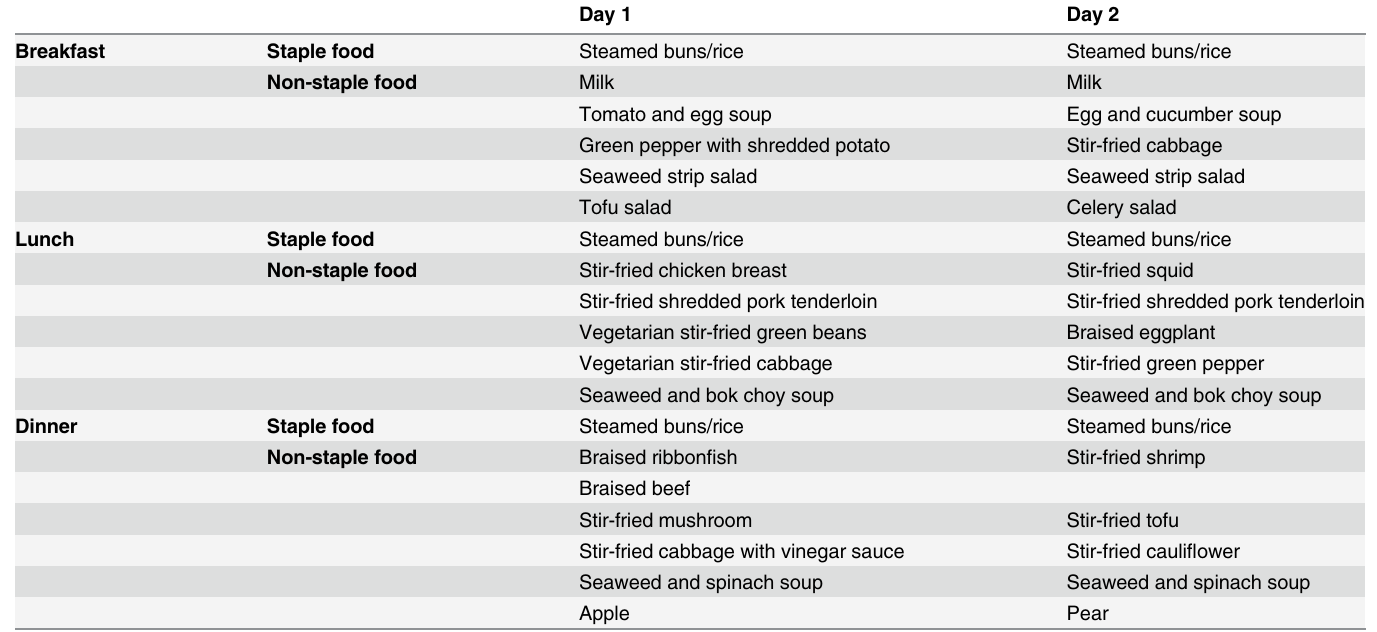
Table 1. Menu for the experimental